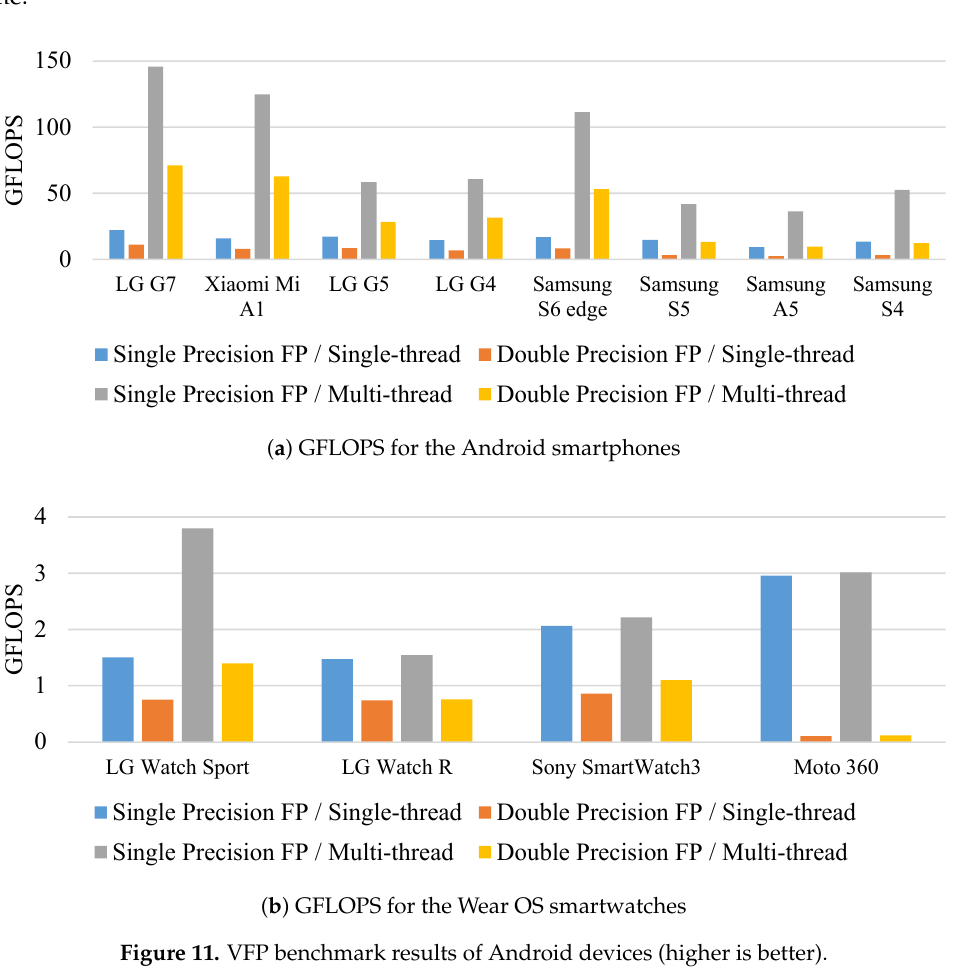
Figure 11. VFP benchmark results of Android devices (higher is